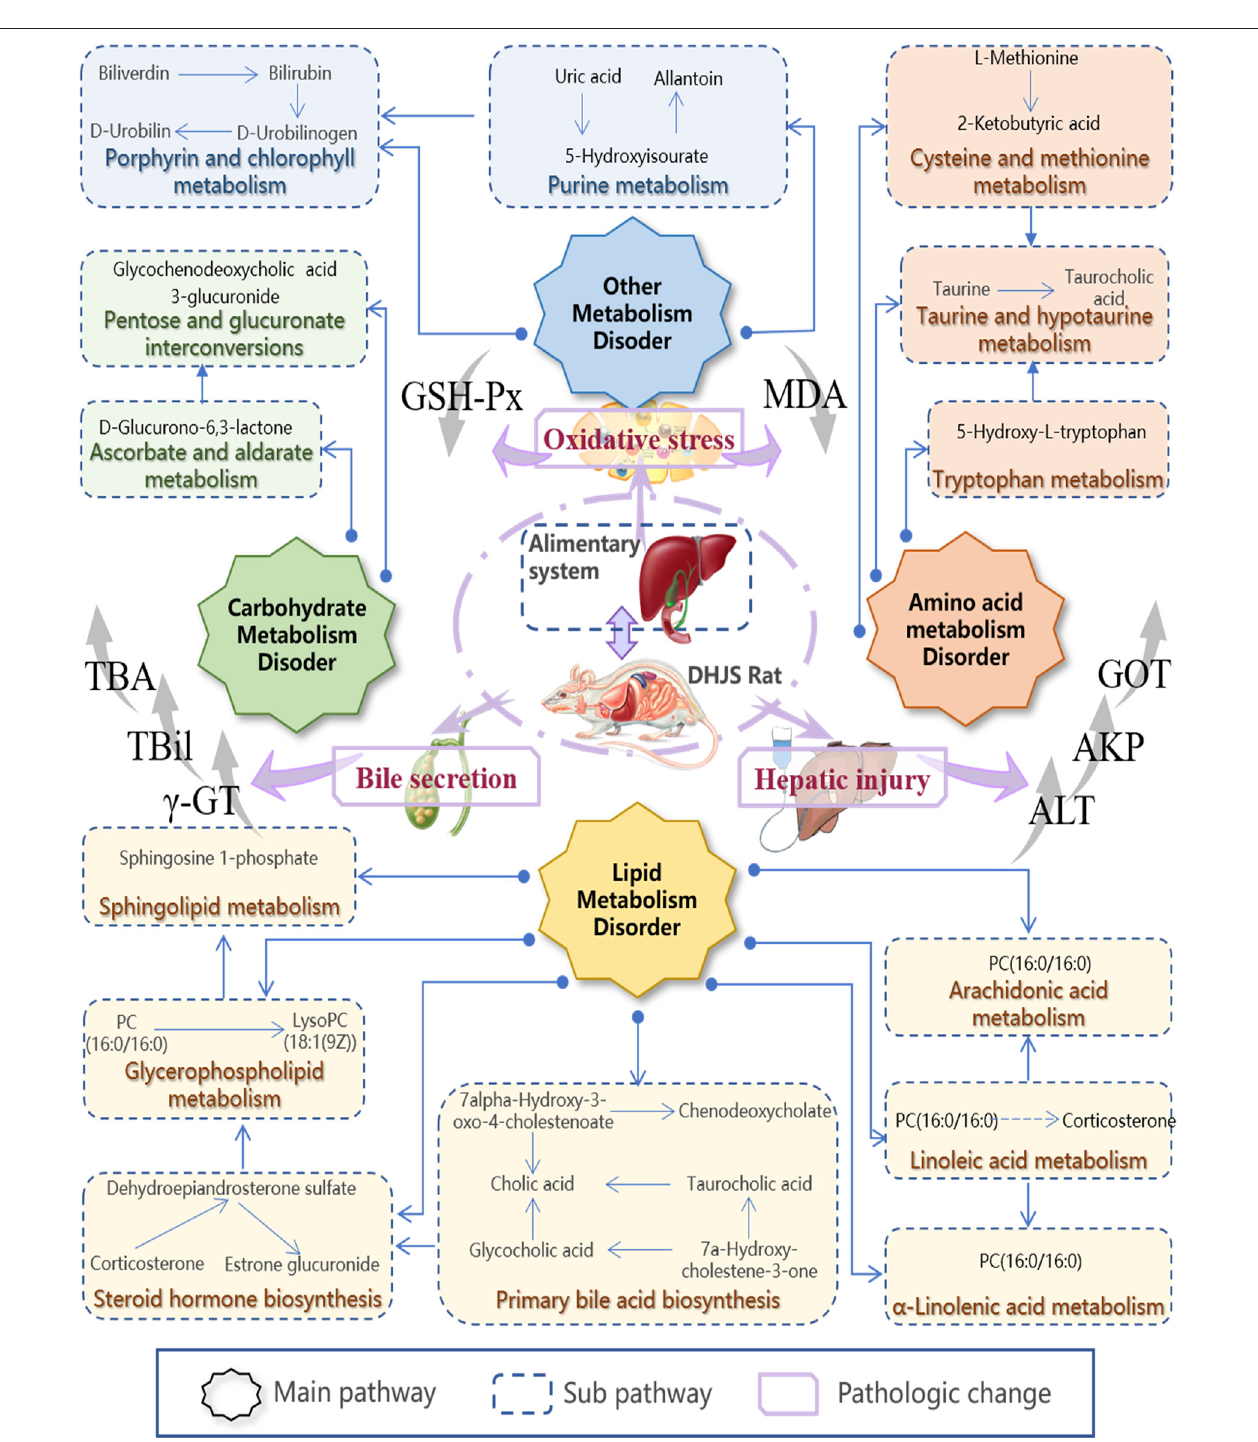
FIGURE 4 | Construction of the altered metabolic network-associated DHJS model based on the KEGG pathway database.